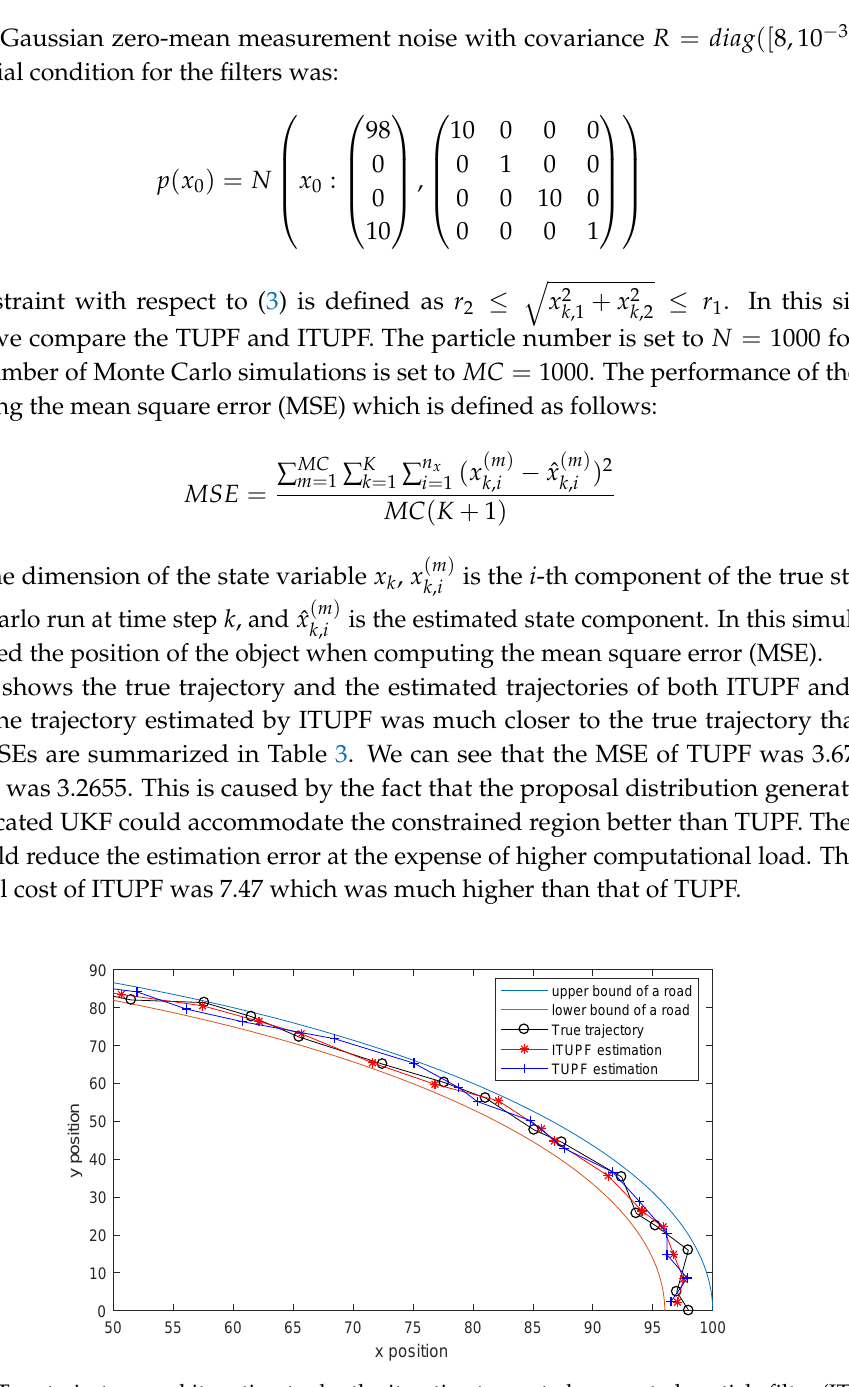
Figure 8. True trajectory and its estimates by the iterative truncated unscented particle filter (ITUPF) and truncated unscented particle filter